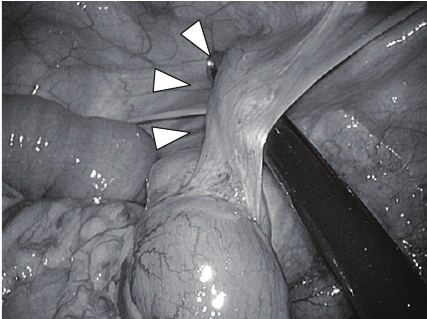
Figure 1: An abdominal computed tomography showed a small bowel dilatation with a caliber change (arrowhead).